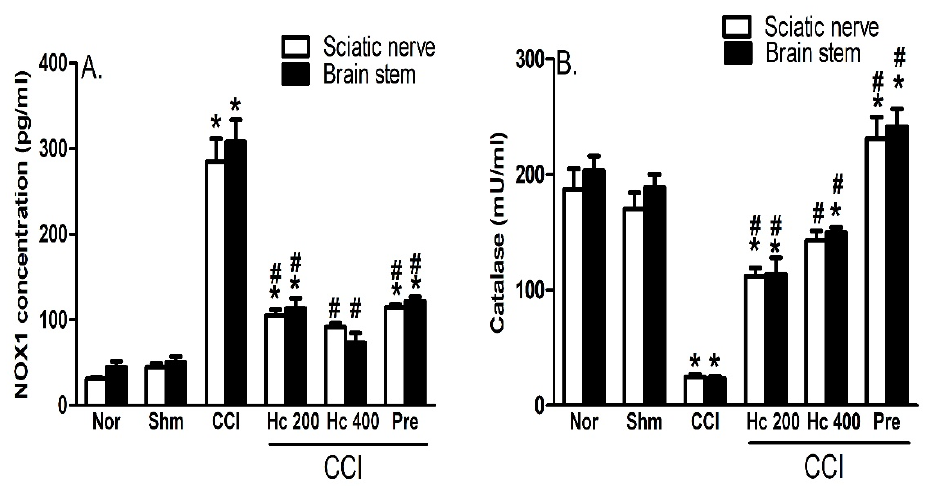
Figure 10. E ff ect of H. campechianum flower extract (p.o., 200 and 400 mg / kg) on CCI-induced rise in NOX1 level ( A ) and catalase activity ( B ) in the brain stems and sciatic nerves of CCI rats. Values are given as mean ± S.E.M., n = 5 rats/group. * p < 0.05, compared to the sham group; # p < 0.05, compared